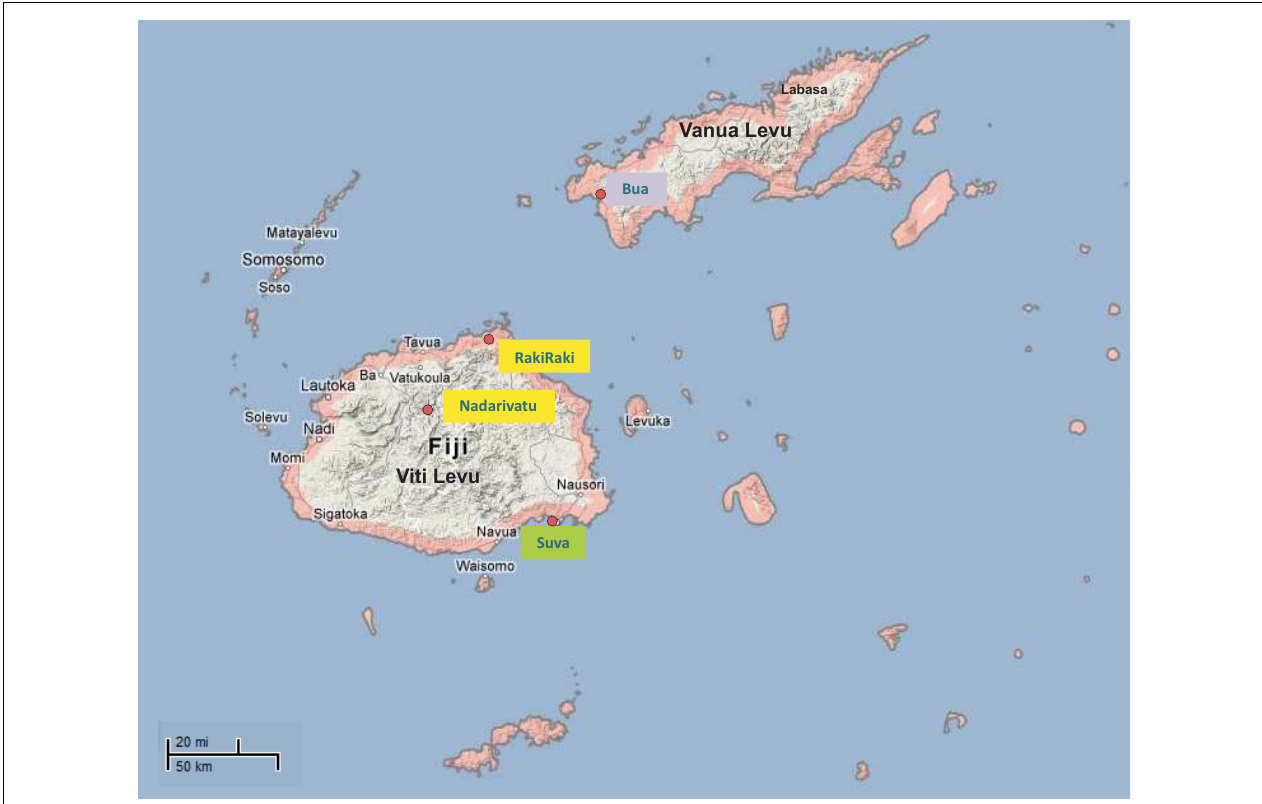
rural Indian settlements in Northern regions of the second large island of Fiji (Vanua Levu): Bua region (Vatubogi and Luvuluvu) in blue, and from Melanesian and Indian Fijians living in the capital city of Fiji, Suva from which all of the urban samples were obtained, indicated in